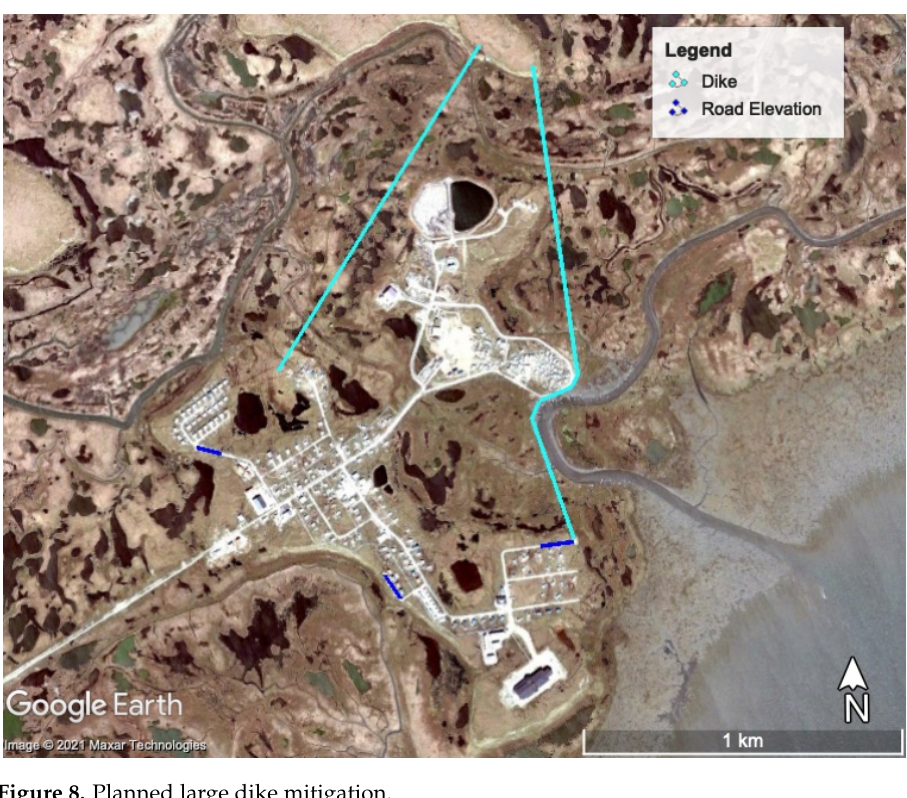
Figure 7. Model points used to estimate the roadside dike height.